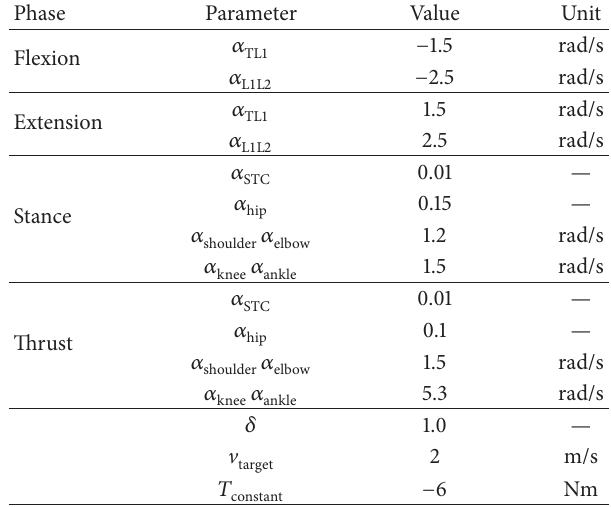
Table 4: Parameter values of the controller used in